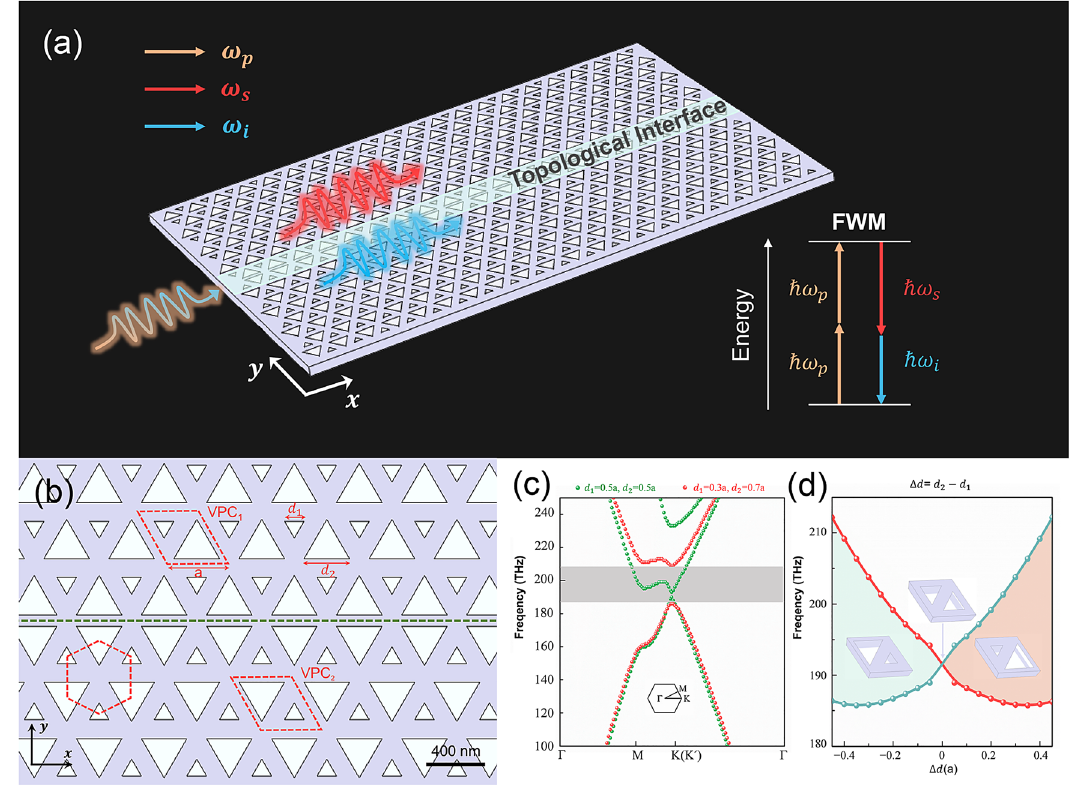
Figure 1: Diagram of the on-chip VPC topological insulators. (a)Geometryofsilicon-basedVPCsimplementingtopologicalvalleykinkstates,theinsetshowsenergyconversionofnonlinearFWMprocess. (b)2Dclose-upimageofVPCswithlatticeconstant a =410nm,greendashedlinedenotestheinterfacebetweenVPC 1 ( d 1 =0.3 a , d 2 =0.7 a